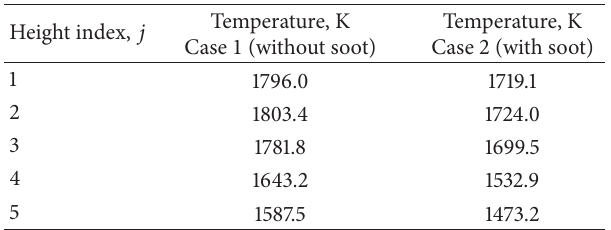
Table 3: Temperature distribution in furnace with and without soot effect, 𝑖 = 1 and 𝑗 = 1, 2, .. ., 5 .